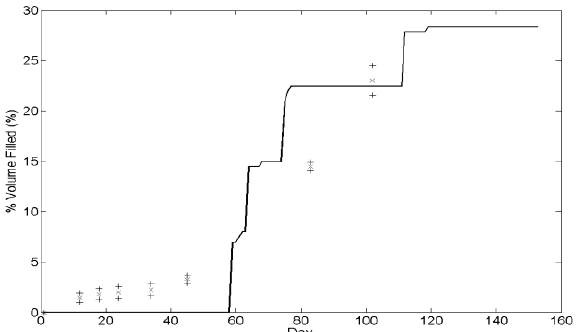
Fig. 3 Model calibration using sediment accumulation data for the River Ithon study reach.